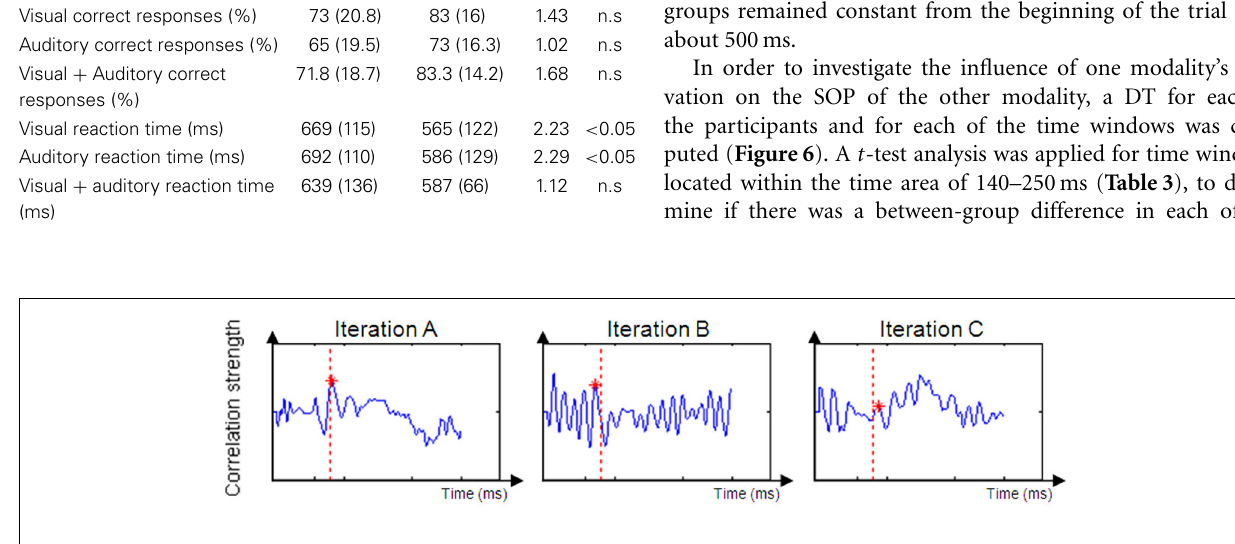
window. Iteration (B) ’s dataset is too noisy to suppose that the value of DT is reliable. Iteration (C) ’s peak is to low and expresses a weak correlation between the two